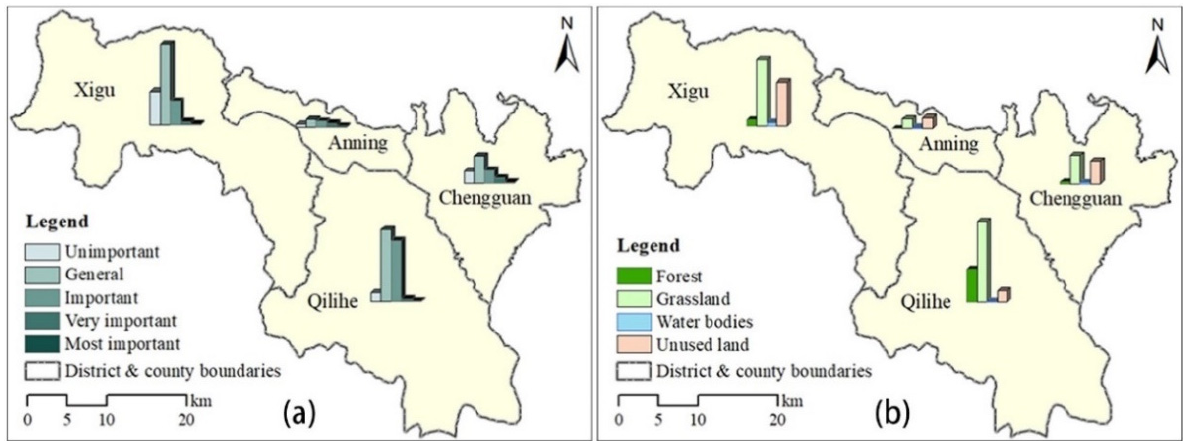
Figure 7. Distribution of various types of ecological land in different regions: ( a , b ) show the proportions of ecological land with different importance levels and various land types, respectively, in the core urban districts of